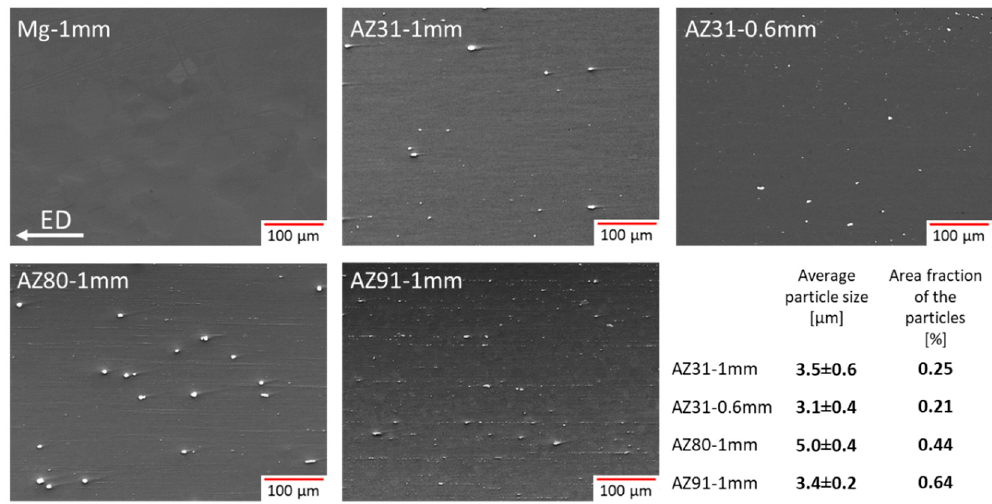
Figure 3. Scanning electron microscope (SEM)-Image with backscatter contrast (BSE)—contrast of all wires from the longitudianlsection in 500× magnification.